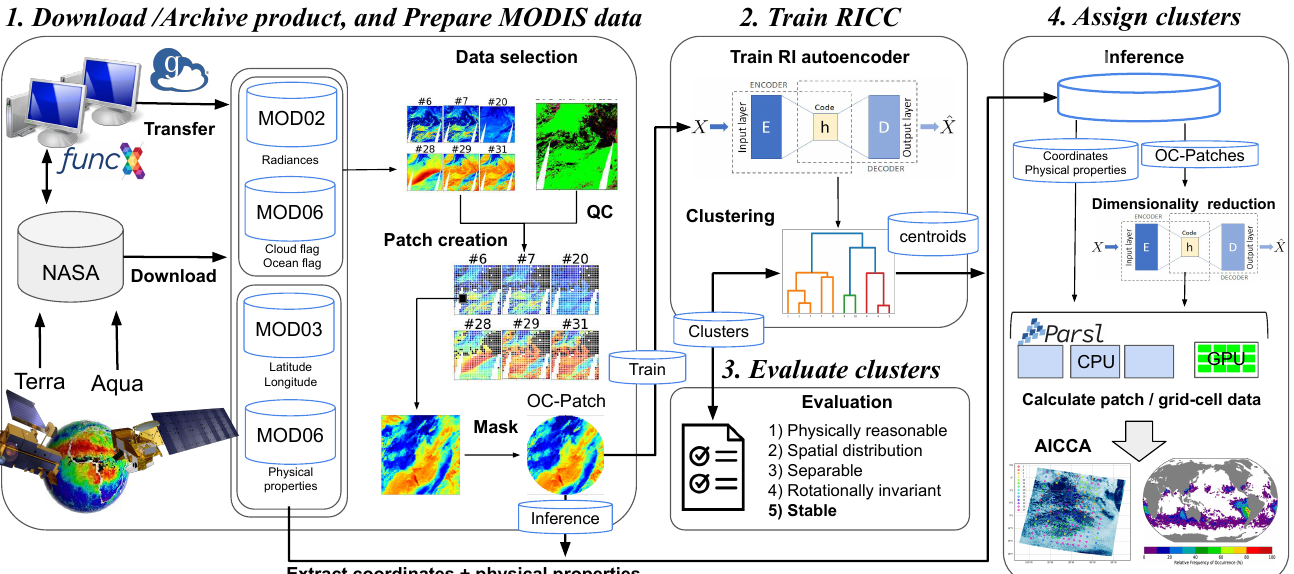
Figure 1. The AICCA production workflow comprises four principal stages. (1) Download/Archive and Prepare MODIS data : Download calibrated and retrieved MODIS products from the NASA Level-1 and Atmosphere Archive and Distribution System (LAADS), using FuncX and Globus for rapid and reliable retrieval of 801 terabytes of three different MODIS products between 2000–2021. Store downloaded data at Argonne National Laboratory. Select six near-infrared to thermal bands related to clouds and subdivide each swath into non-overlapping 128 × 128 pixel patches by six bands. Select patches with >30% cloud pixels over ocean regions, and apply a circular mask for optimal training of our rotation-invariant autoencoder, yielding OC-Patches . (2) Train RICC : Train an autoencoder on 1 M randomly selected patches to generate latent representations, and cluster those latent representations to determine cluster centroids [18]. (3) Evaluate clusters : Apply five protocols to evaluate whether the clusters produced are meaningful and useful. (4) Assign clusters : Use trained autoencoder and centroids to assign cloud labels to unseen data. We use the Parsl